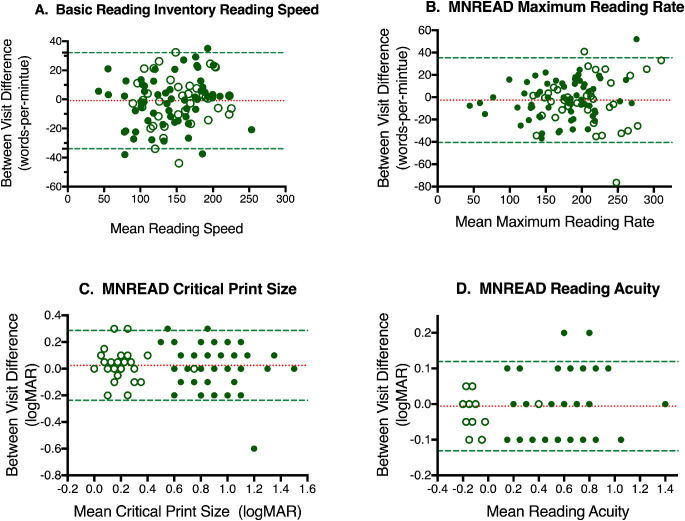
Difference versus mean plots (Bland–Altman) comparing results from visits 1 and 2. Open circles denote participants with normal vision, and closed circles denote participants with VI. Red dotted lines indicate the mean difference between the two measures. Green dashed lines indicate ±1.96 SD.